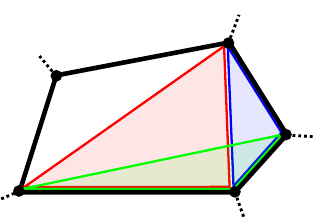
Figure 11 . Illustrative example of the algorithm to triangulate a non-simplicial cone. Here we consider a 3-dimensional fan and draw its intersection with the unit-sphere S 2 . The non-simplicial cone of the totally positive tropical con(cid:12)guration space is drawn in black. The red, green and blue cones are part of the set of all cones that may be used for the triangulation. If the algorithm has already picked the red one for the triangulation, only the blue one can be picked in the next step, as the green one intersects with the red cone and does not share a codimension-1 boundary with